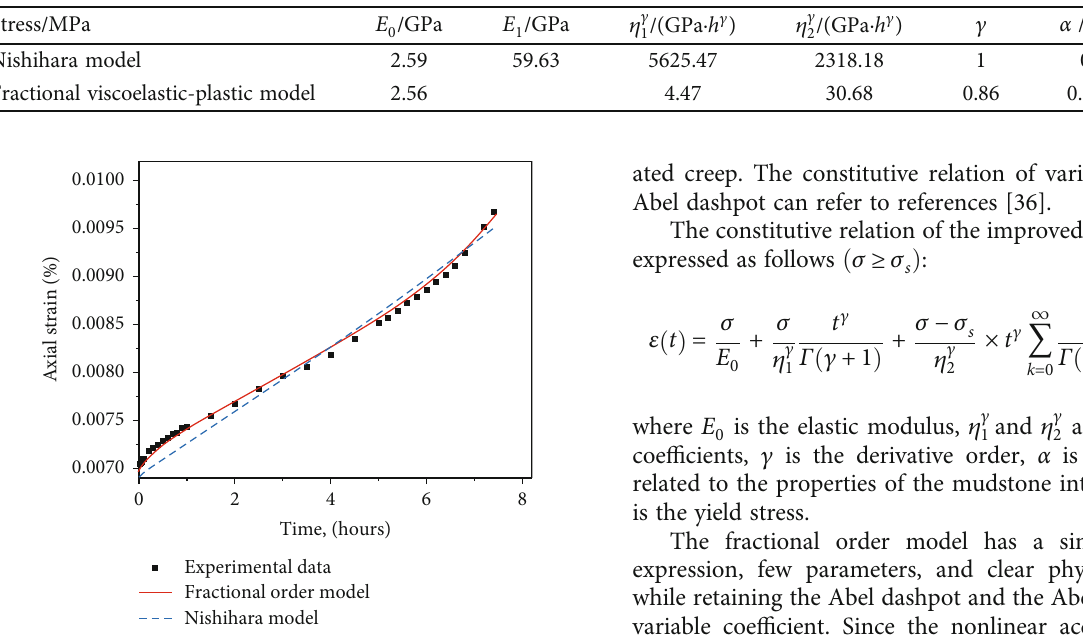
Figure 16: The model fi tting data were compared with the experimental